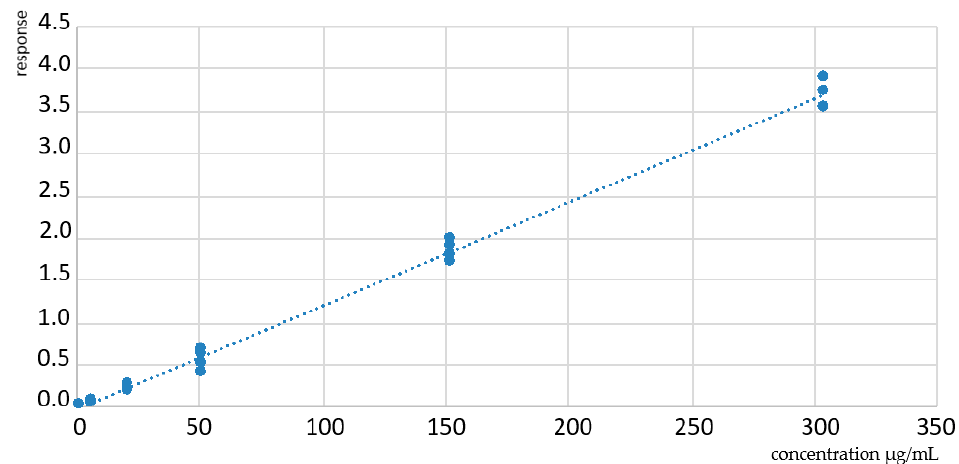
Figure 4. Calibration curve obtained in the blood shows a good linearity in the calibration range (1.0–304.0 µg/mL). The equation and correlation coefficients are reported in Table 1. X axis: concen- tration in µg/mL. Y-axis: response.